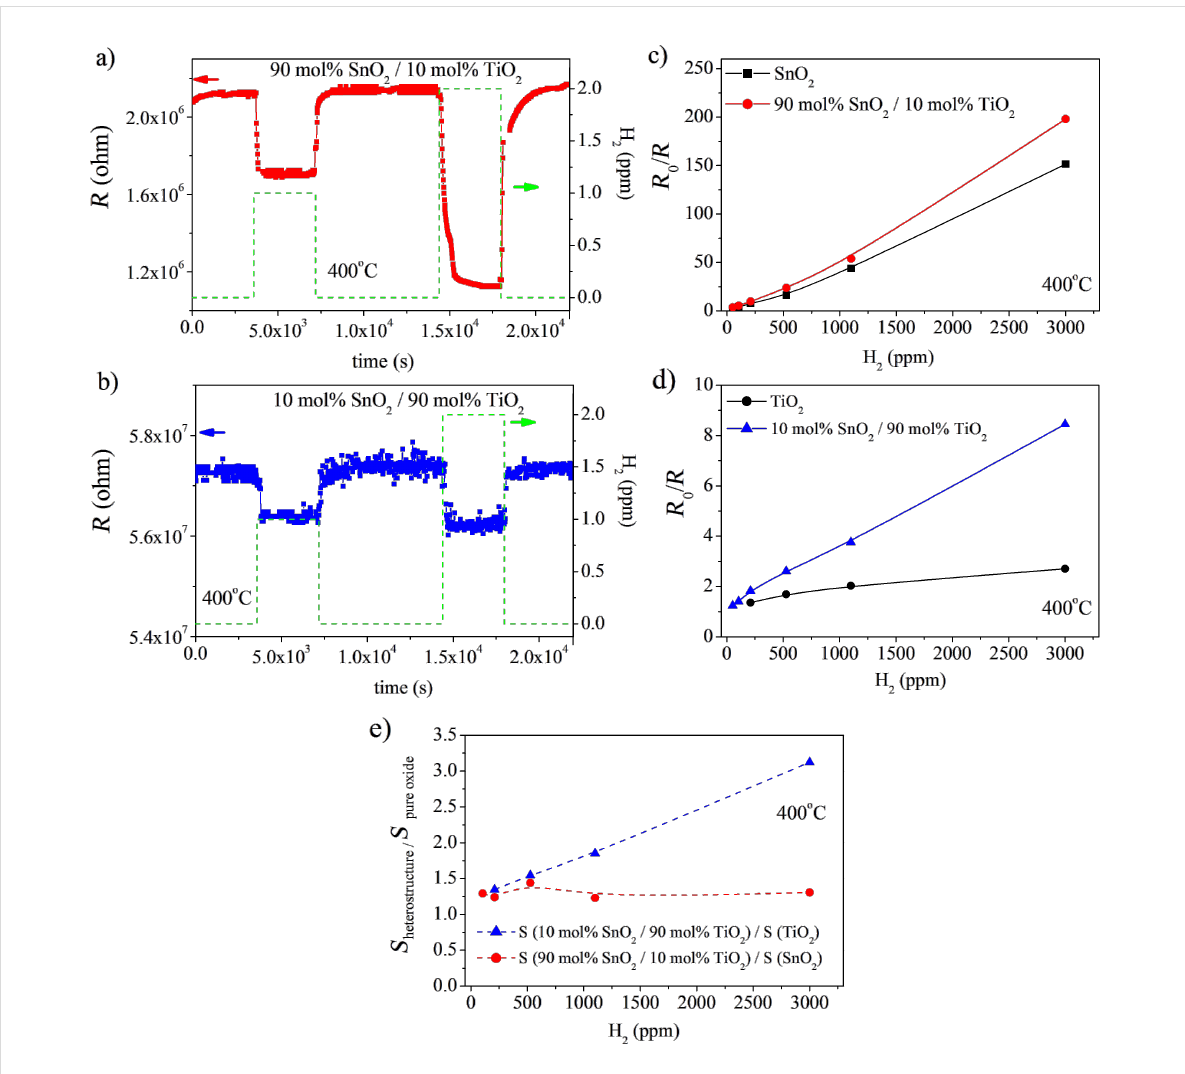
Figure 5: Dynamic changes in the electrical resistance, R , of: a) 90 mol % SnO 2 /10 mol % TiO 2 ; b) 10 mol % SnO 2 /90 mol % TiO 2 nanomaterials upon interaction with 1 and 2 ppm of H 2 along with the corresponding sensor response ( R 0 / R ) as a function of H 2 concentration (c, d). The influence of the formation of heterostructures on the gas-sensing performance is given in e) as the corresponding ratio of responses S heterostructure normalized to those of pure SnO 2 and TiO 2 ( S pure oxide ). The gas-sensor response S is defined in Equation